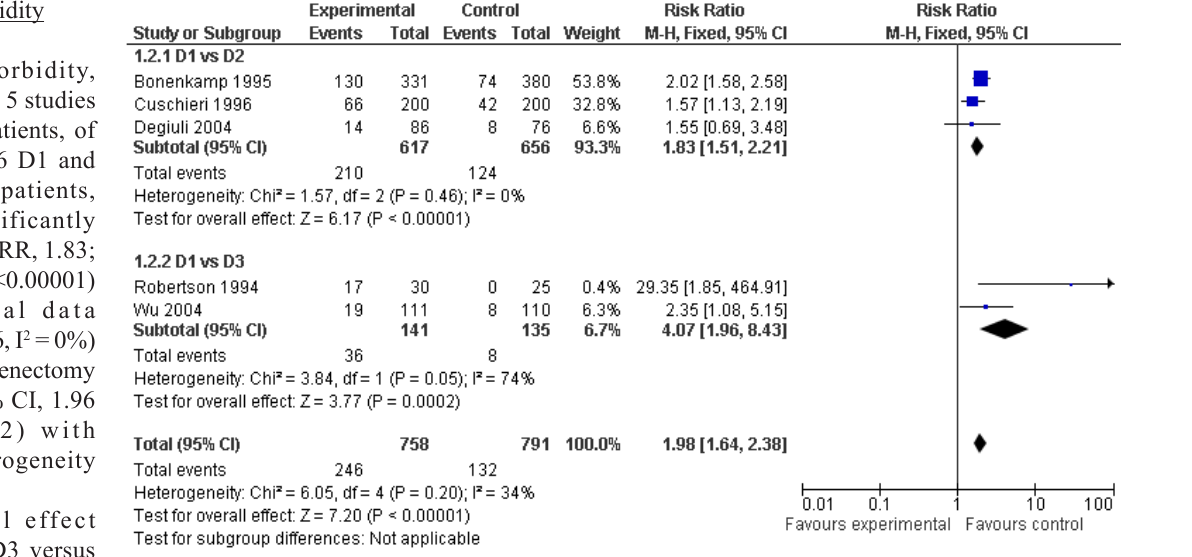
FIGURE 2 – Meta-analysis of overall morbidity. Effects estimates (odds ratio; 95% CI). Pooled treatment effect is shown as a diamond that spans the 95% CI. No statistical heterogeneity between D1 x D2 studies results. Overall effect with significant statistical difference favouring D1 lymphadenectomy (p<0,00001)